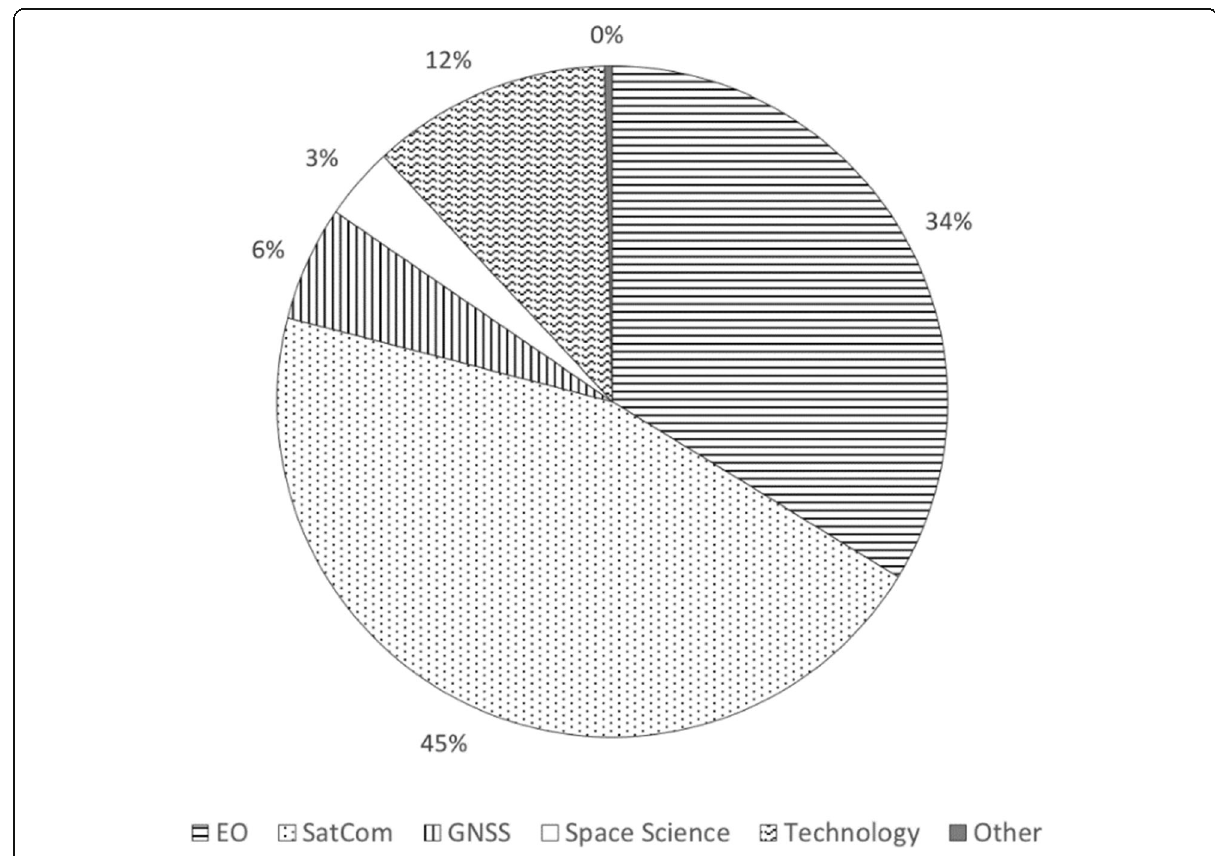
Fig. 14 Share of technologies used by the operational satellites in orbit, as of March